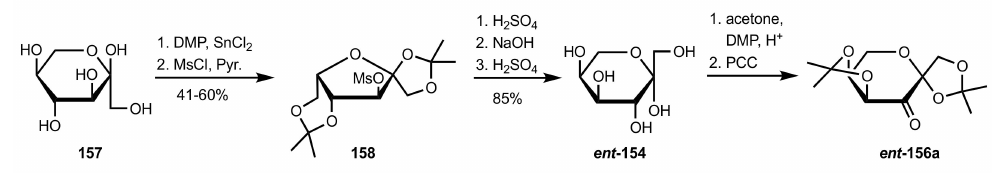
Asymmetric epoxidation catalysed by ent -156a afforded the oxirane with the opposite configuration in equal enantiomeric excess (Scheme 37)